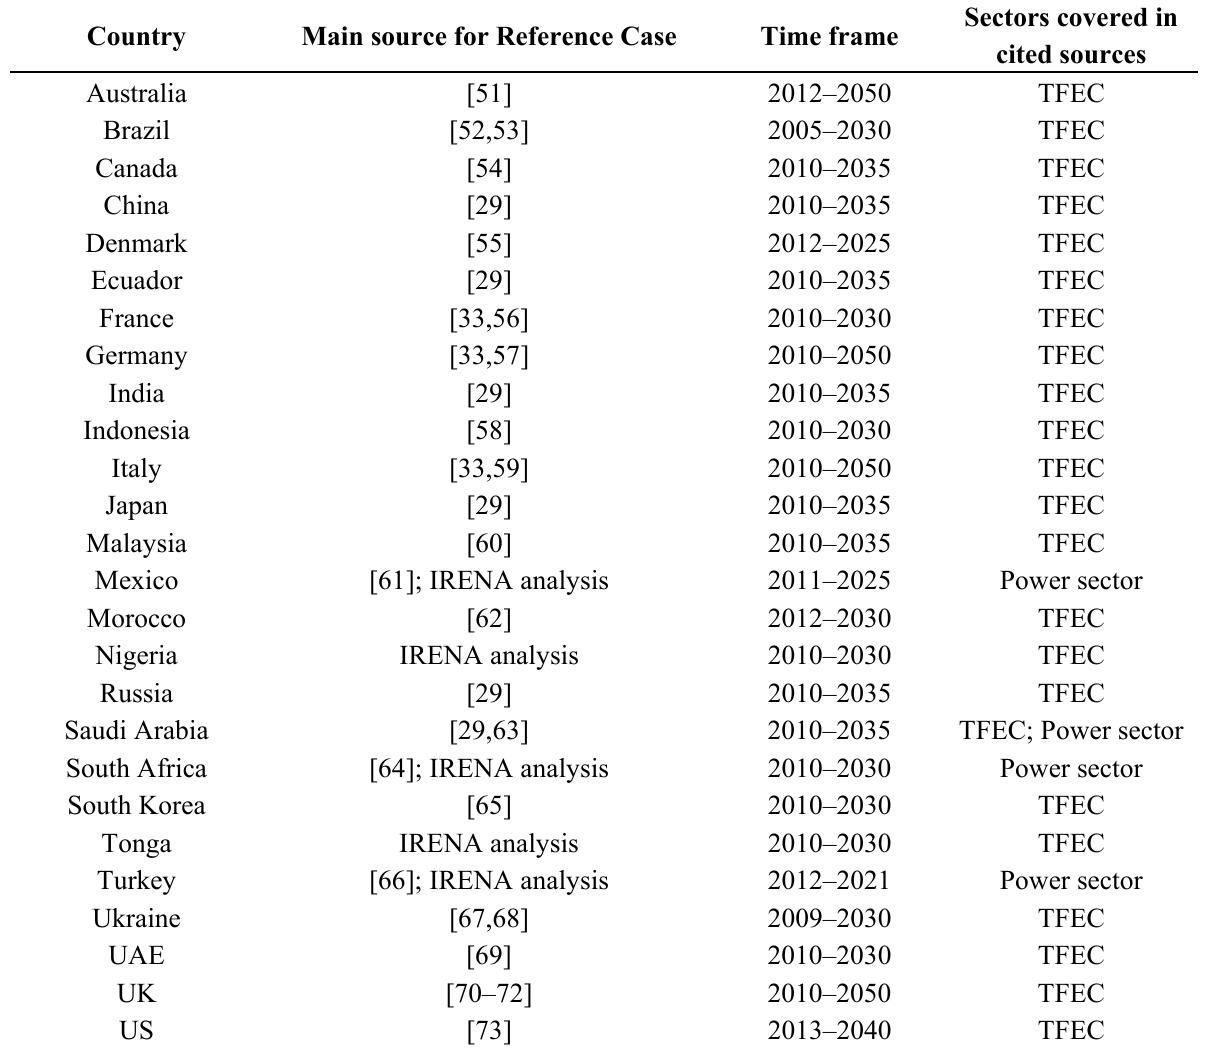
Table A1. Bibliographic sources that complement IRENA analysis for the Reference Case of the 26 REmap countries.